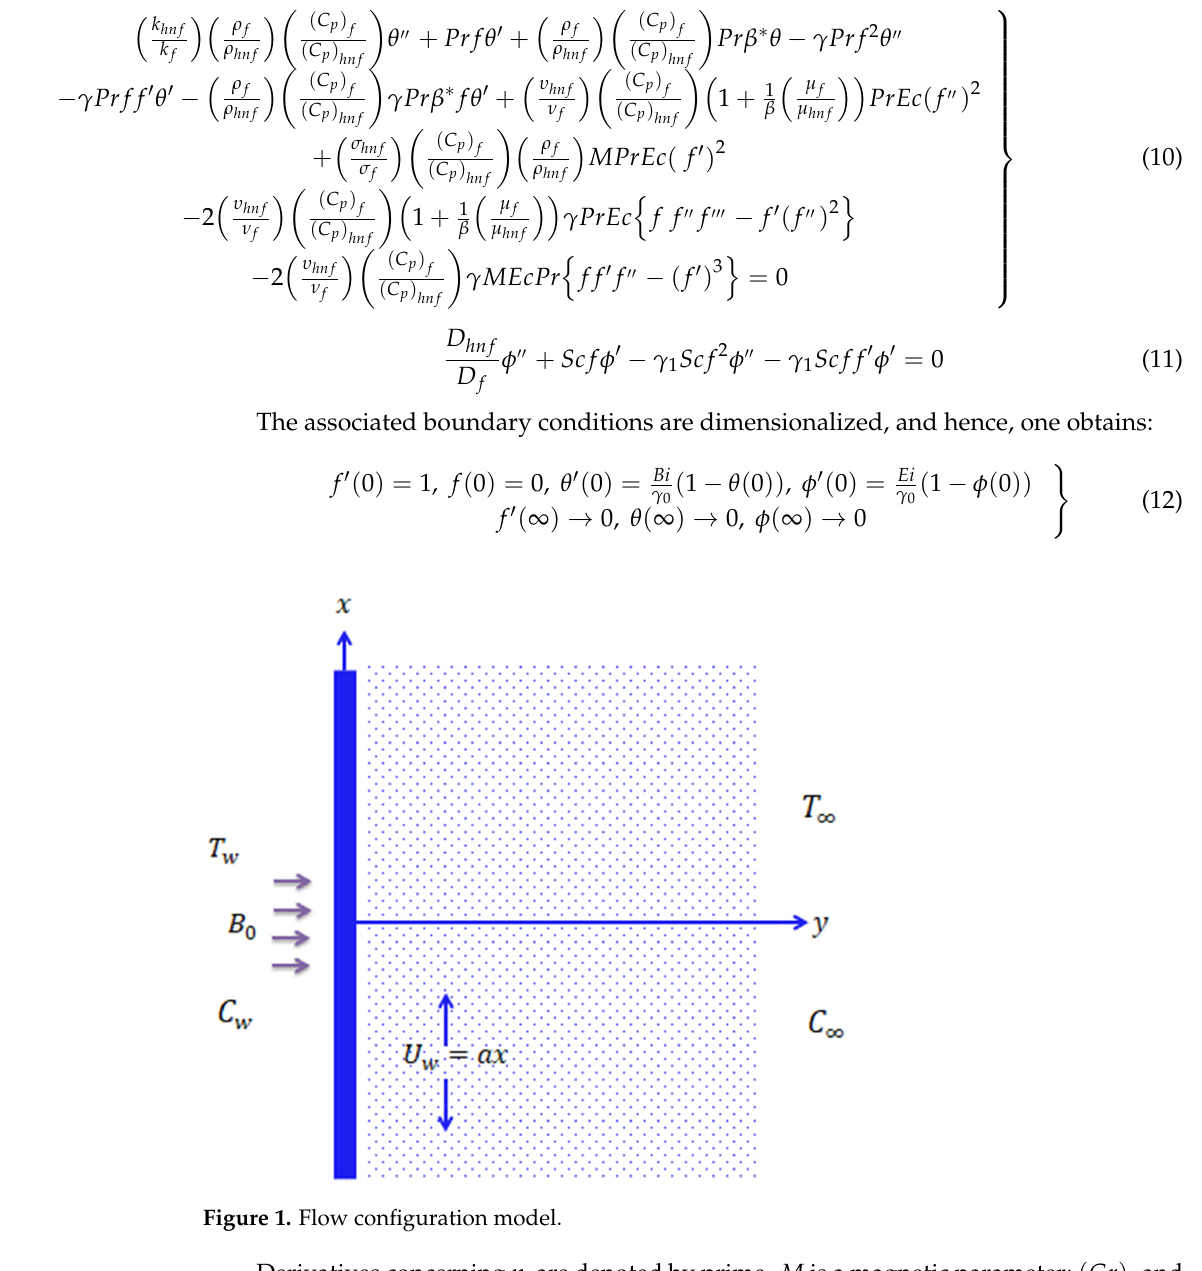
Table 1. Values of properties of pure fluid and nanostructure.